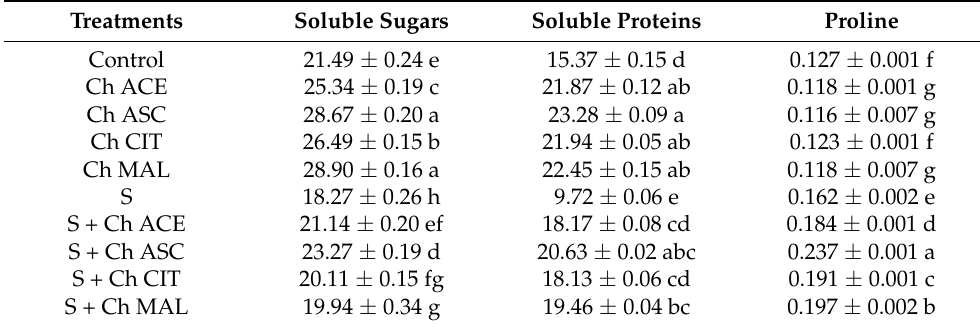
Table 1. Effect of salinity (S) and foliar application of chitosan dissolved in different organic acids (Ch ACE, Ch ASC, Ch CIT, Ch MAL) and their interactions on the content of osmolytes (solu- ble sugars, soluble proteins and proline; mg g − 1 DW) of tomato plants. Data are presented as means ± SE ( n = 3). Data followed by different letters are significantly different following Tukey’s honestly significant difference (HSD) test at p ≤ 0.05. DW: Dry weight.